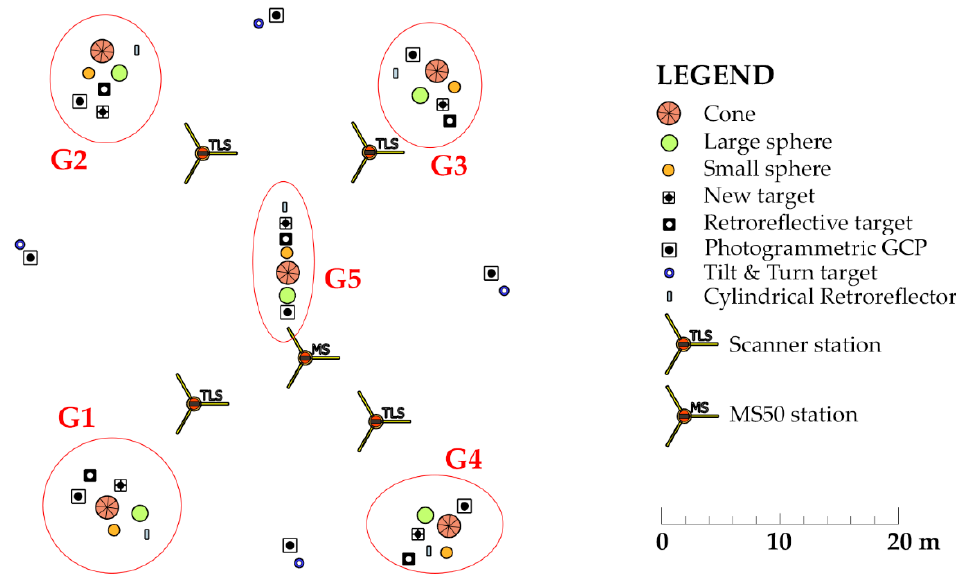
Figure 9. Distribution of targets, TLS scanner stations, and MS50 station throughout the test area.